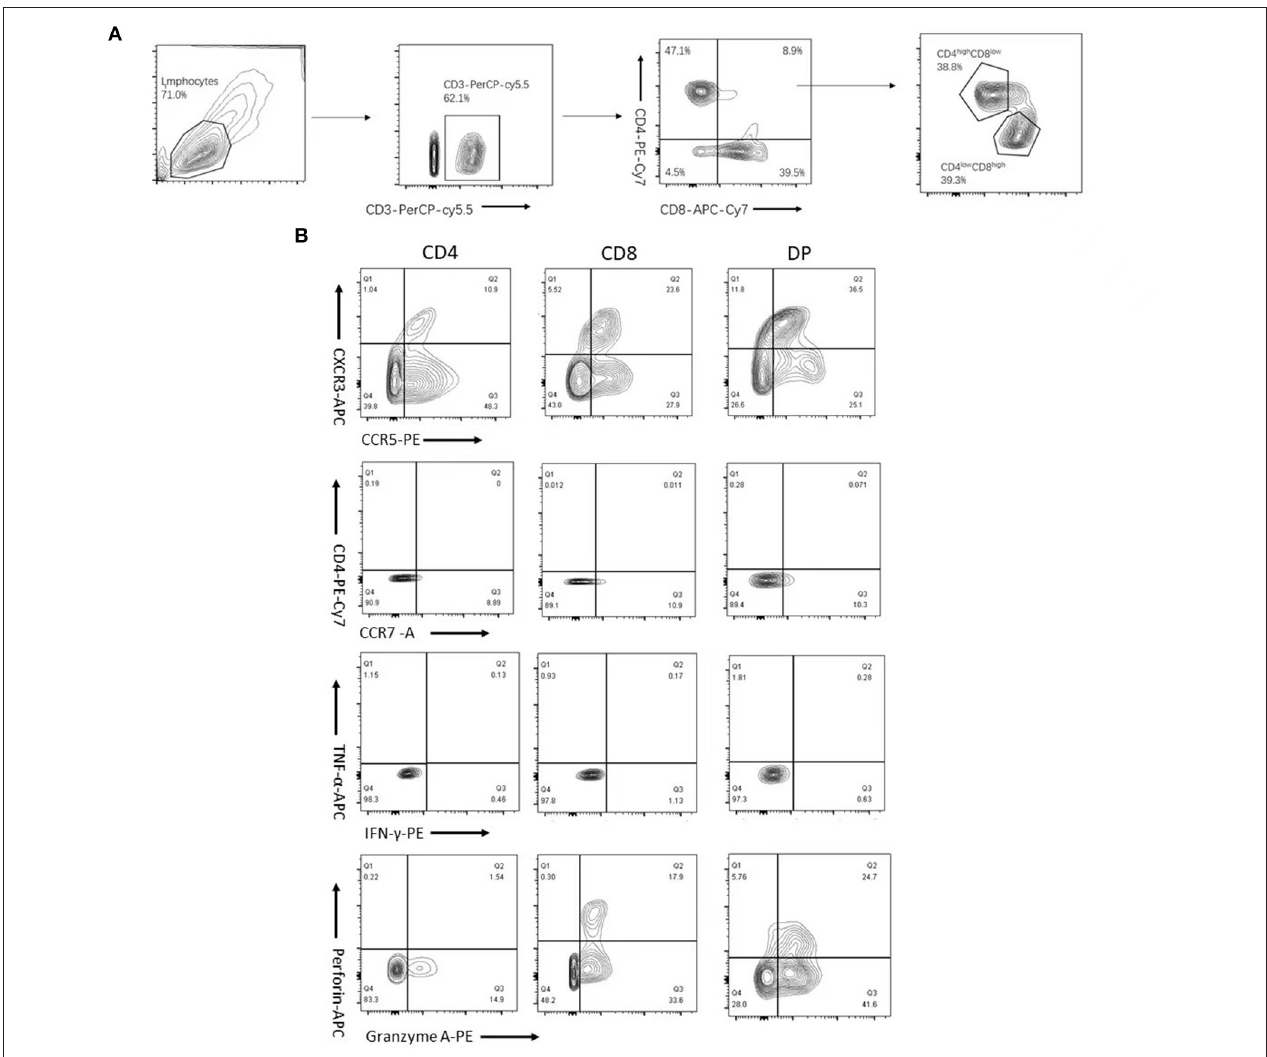
FIGURE 1 | Flow cytometric gating strategy. CD3 + subsets of CD4 + , CD8 + , and CD4 + CD8 + (double-positive (DP)) T cells were gated as described in Section “Materials and methods.” And DPT cells were further divided into CD4 high CD8 low and CD4 low CD8 high T cells based on the expression levels of CD4 and CD8 molecules (A) . Plots depicting CXCR3, chemokine receptor 5 (CCR5), CXC chemokine receptor 4 (CXCR4), CCR7, interferon-gamma (IFN- γ ), tumor necrosis factor α (TNF- α ), perforin, and granzyme A expression or production of gated CD4 + , CD8 + , and DP T cells (B) are